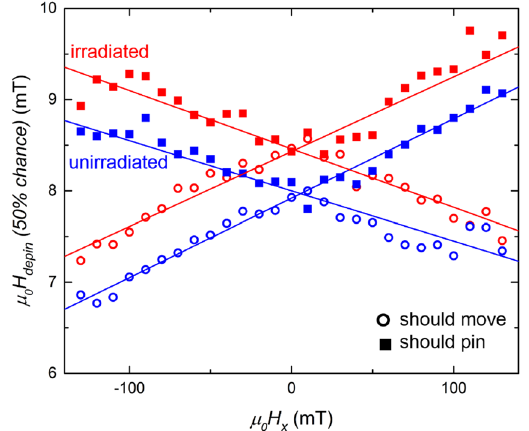
Figure 4. Boundaries for which a domain wall has 50 percent chance to depin, for both the irradiated and unirradiated Pt/Co/Ir sample and for both domain walls that are suppose to remain pinned and for domain walls that are supposed to